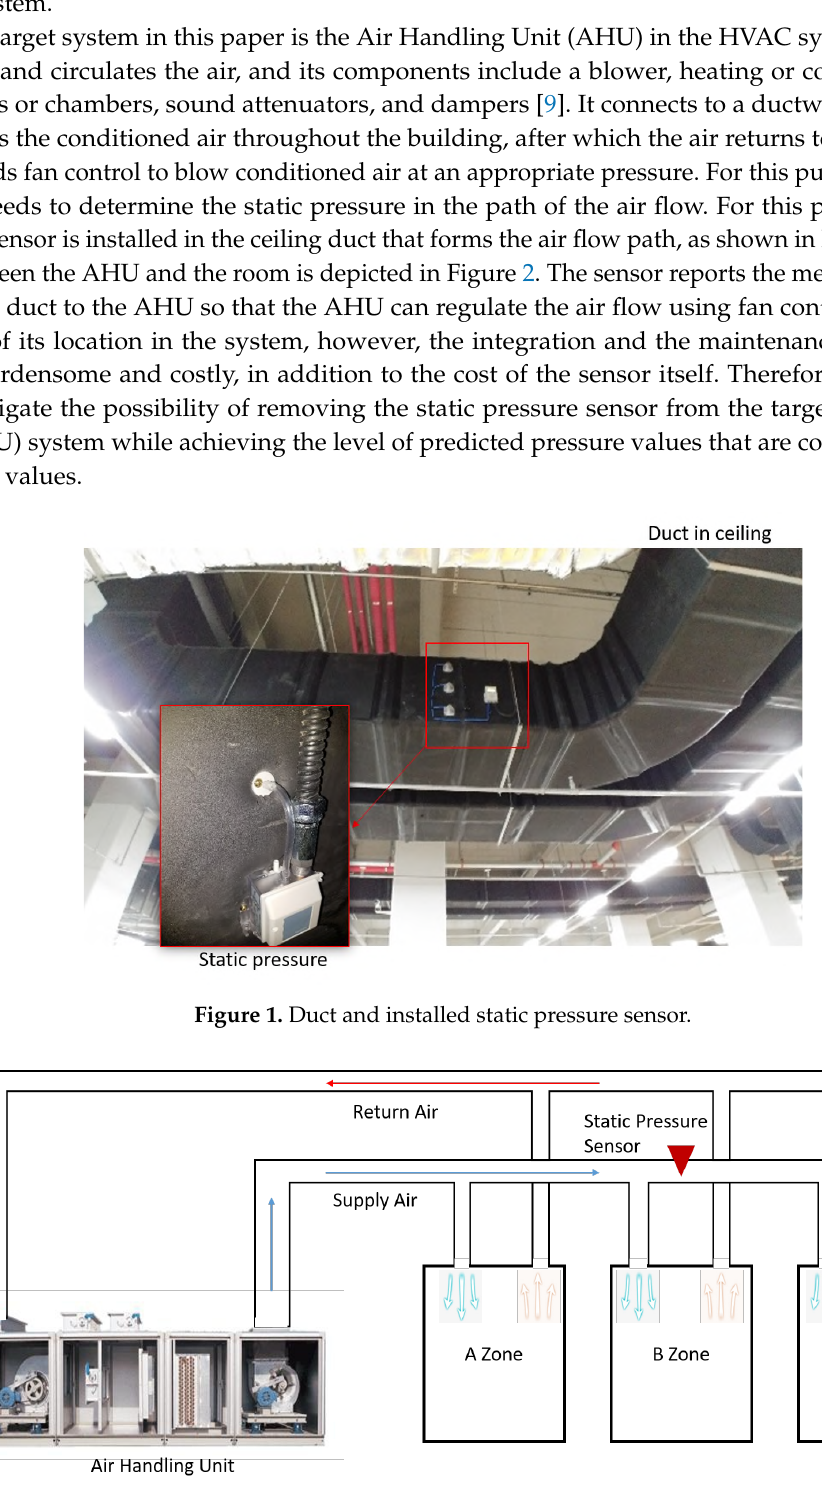
Figure 2. Air flow between the Air Handling Unit (AHU) and the